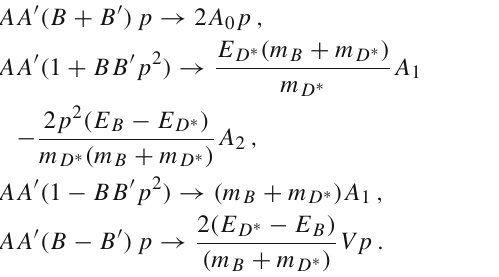
Fig. 8 R D ∗ V , R D ∗ A 0 , h A and R D ∗ A 2 from Eqs. (40), (41), (44), and 1 (45) as a function of w normalized to 1 at w = 1